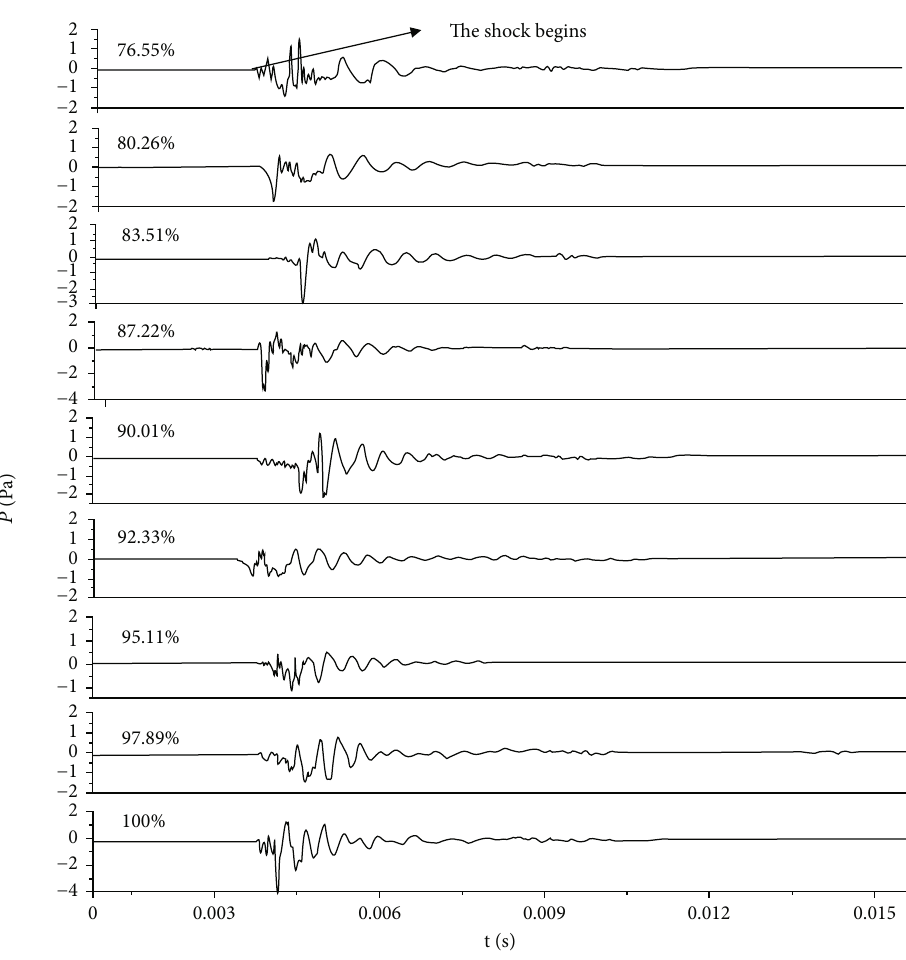
Figure 3: Time-domain diagram of sound information of hammering soil samples.